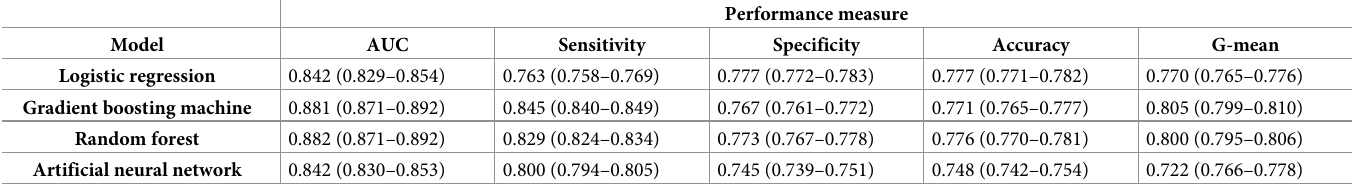
Table 2. Algorithm performance on cross-validated training data (n =